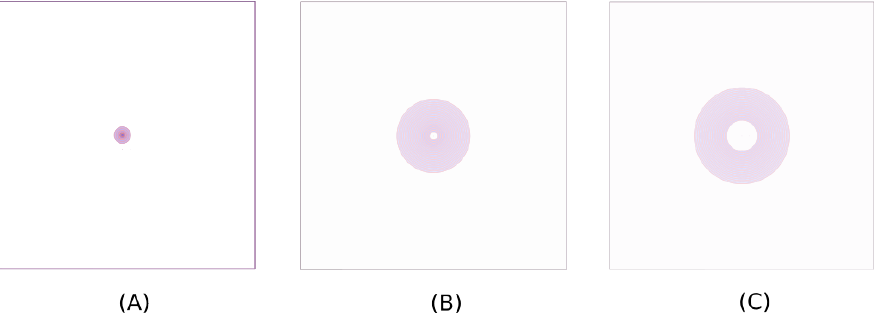
Figure 10. Snapshots of the electric field distribution ( E z ) for the free space at 2.45 GHz frequency. ( A – C ) show the images at 150, 650, and 700 time-steps, respectively. The simulation was carried out during 1160 time steps.